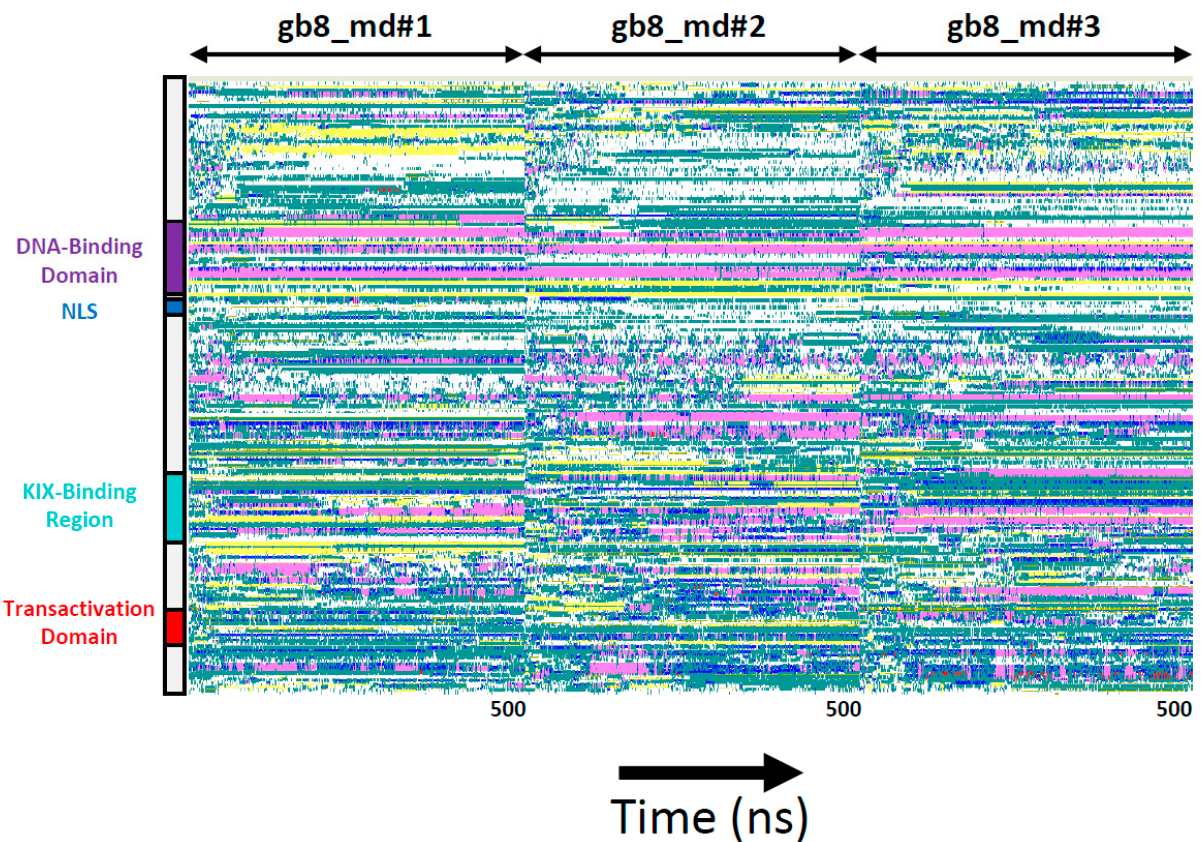
Figure 3. Distribution of secondary structure elements in molecular dynamics (MD) simulations. The distribution of secondary structure elements is shown for the first three MD simulations as representative examples (gb8_md#1, gb8_md#2, gb8_md#3). The vertical axis represents the primary amino acid positions, highlighting functionally relevant domains as colored boxes). The horizontal axis represents simulation time (1–500 nanoseconds (ns) for each of the three independent simulations). The data are represented in concatenated format to allow direct comparison between the different trajecto- ries. The color codes represent the secondary structures formed in each simulation frame at each position of the primary amino acid sequence (pink, α -helix; dark blue, π -helix; yellow, extended conformation; cyan, turn; white, coil). Data vis- ualized with VMD [34].